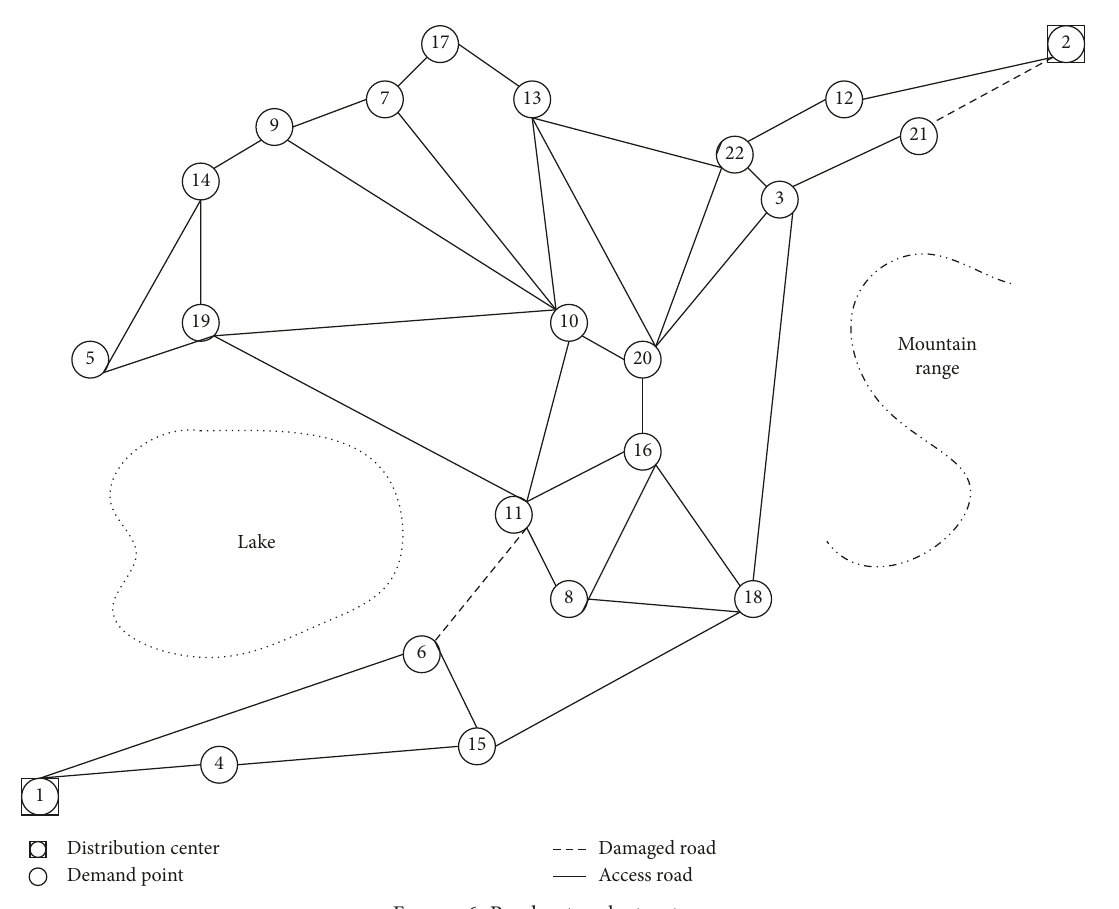
Figure 6: Road network Table 3: Subpath transport route without road repair.